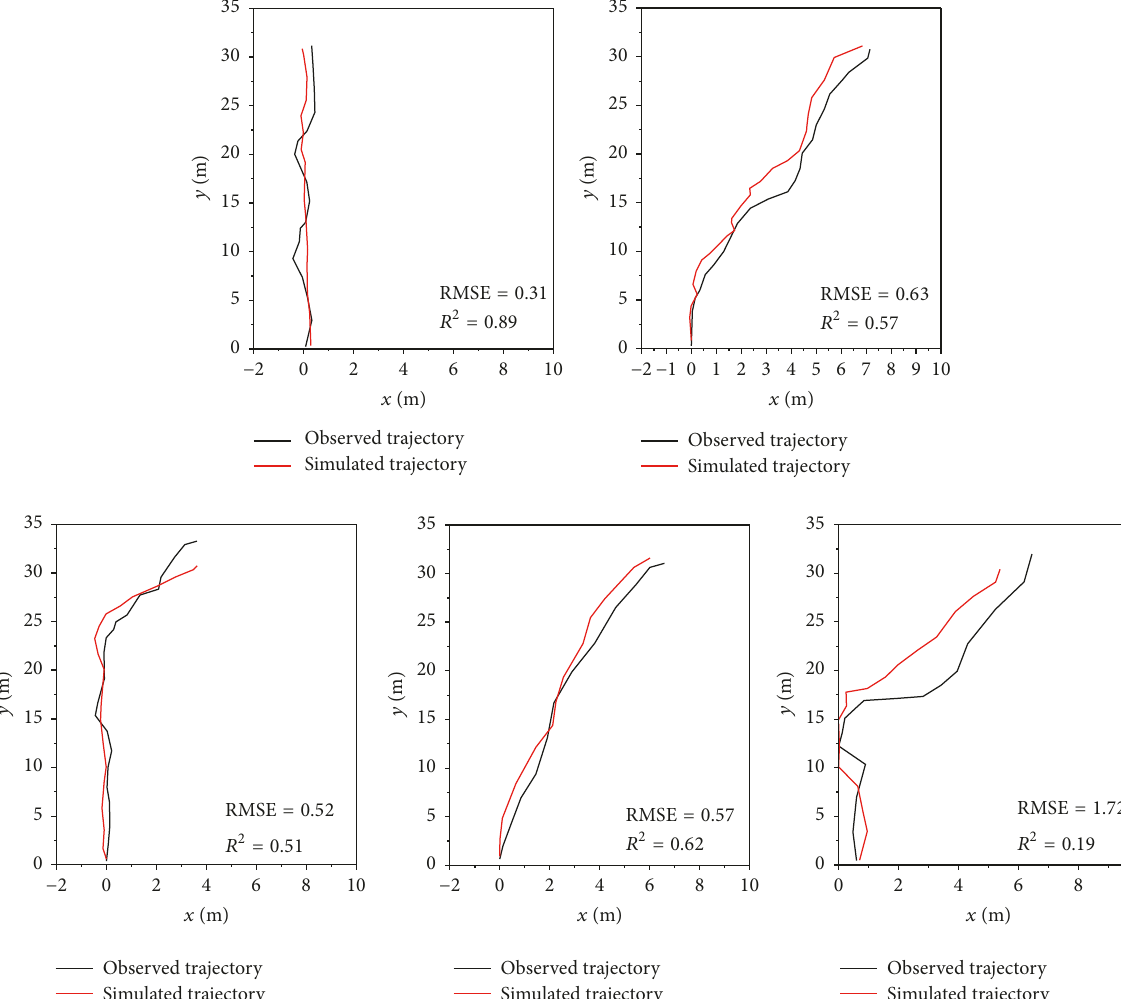
Figure 15: Examples of simulated and observed pedestrian trajectories for five path